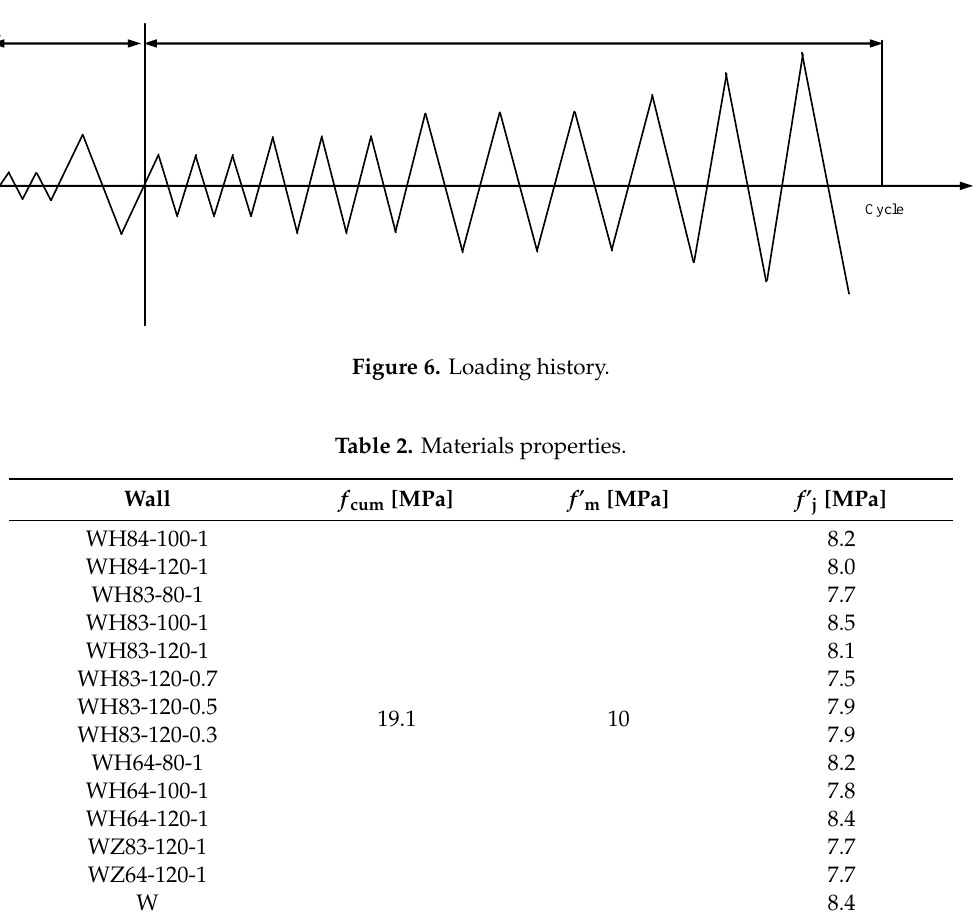
6. Displacement sensor; 3-1–3-8. Strain gauge).